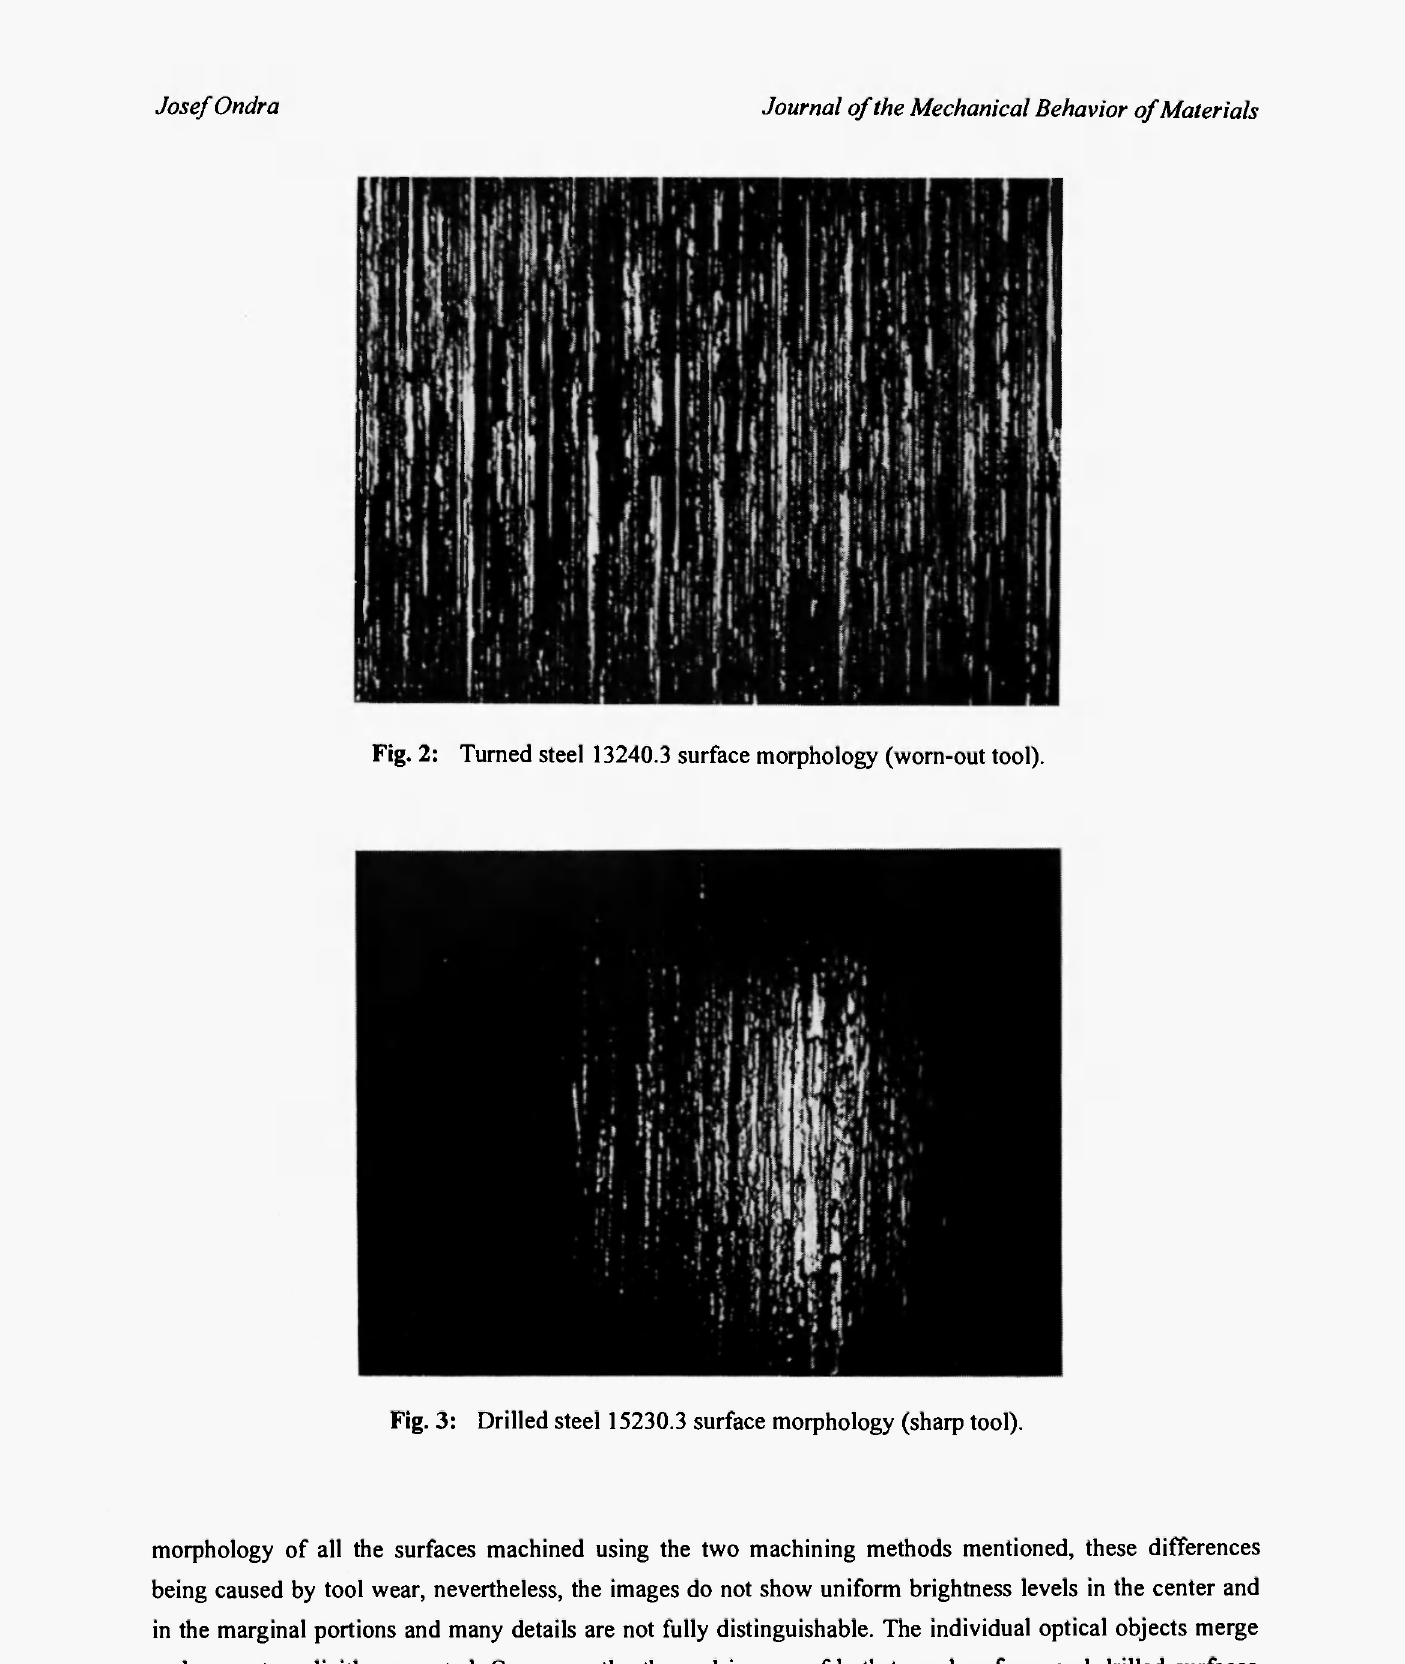
Fig. 2: Turned steel 13240.3 surface morphology (worn-out tool).